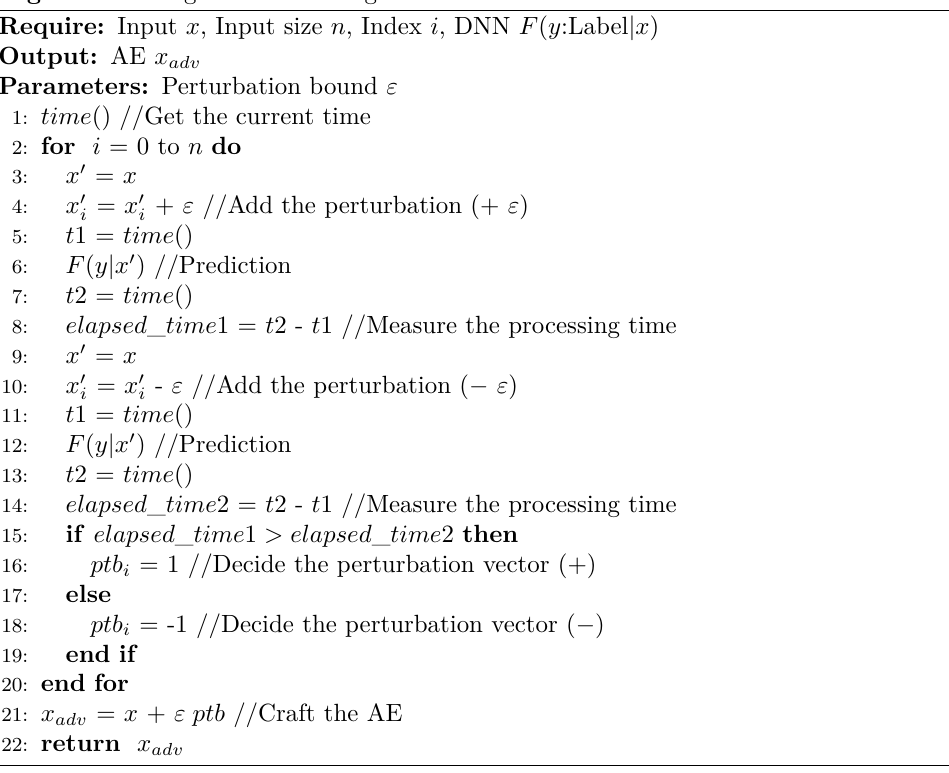
Algorithm 1 Algorithm of timing black-box attacks in ReLU function